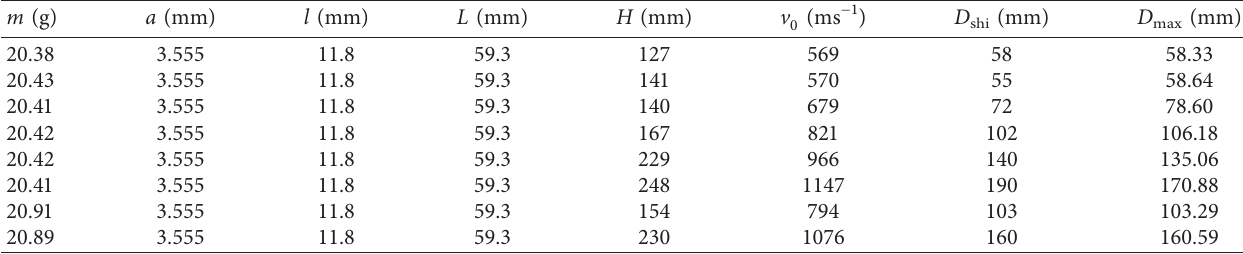
Table 1: Comparisons of the analytical results of penetration depth.